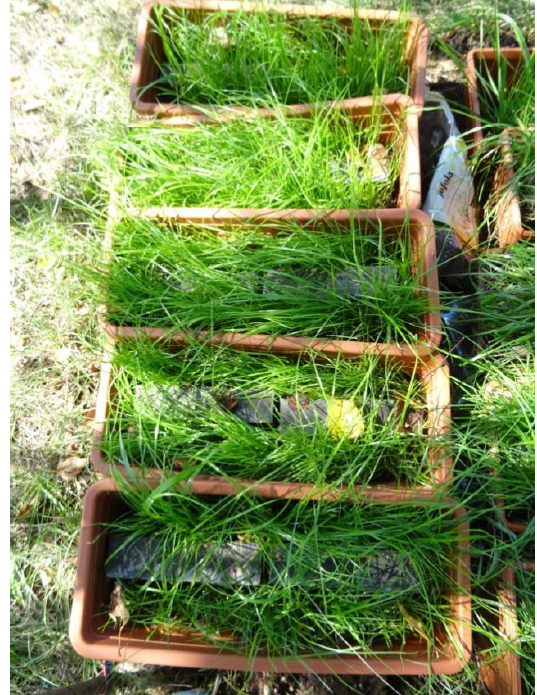
Figure 16. Grass condition in Series 2 after 30 days (B. Vojvodikova).